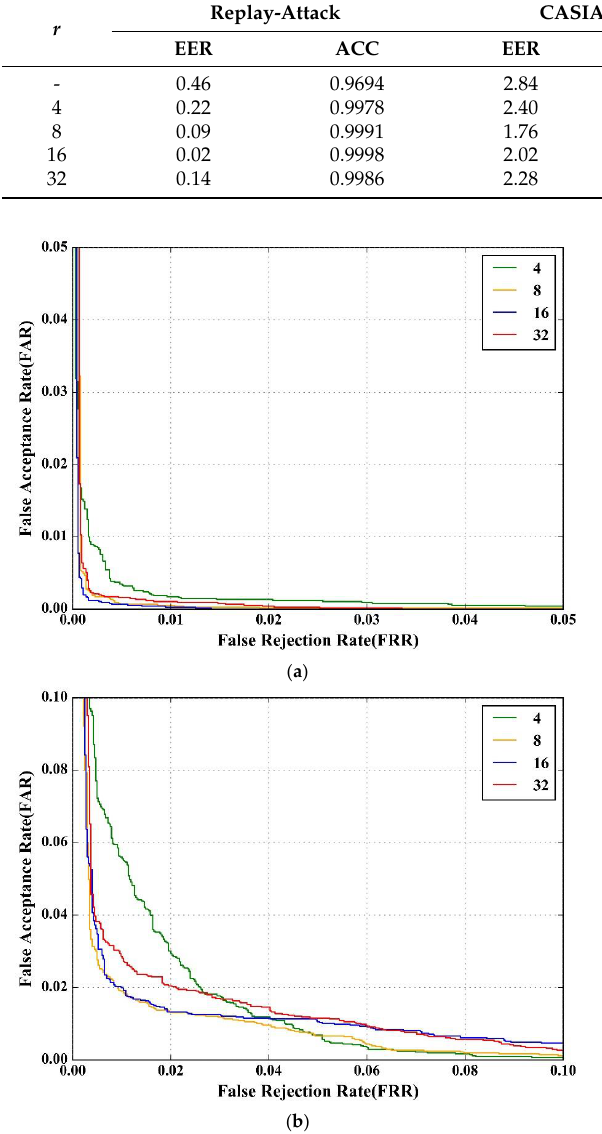
Figure 11. ROC curves for different r values. ( a ) Replay-Attack. ( b ) CASIA-FASD.